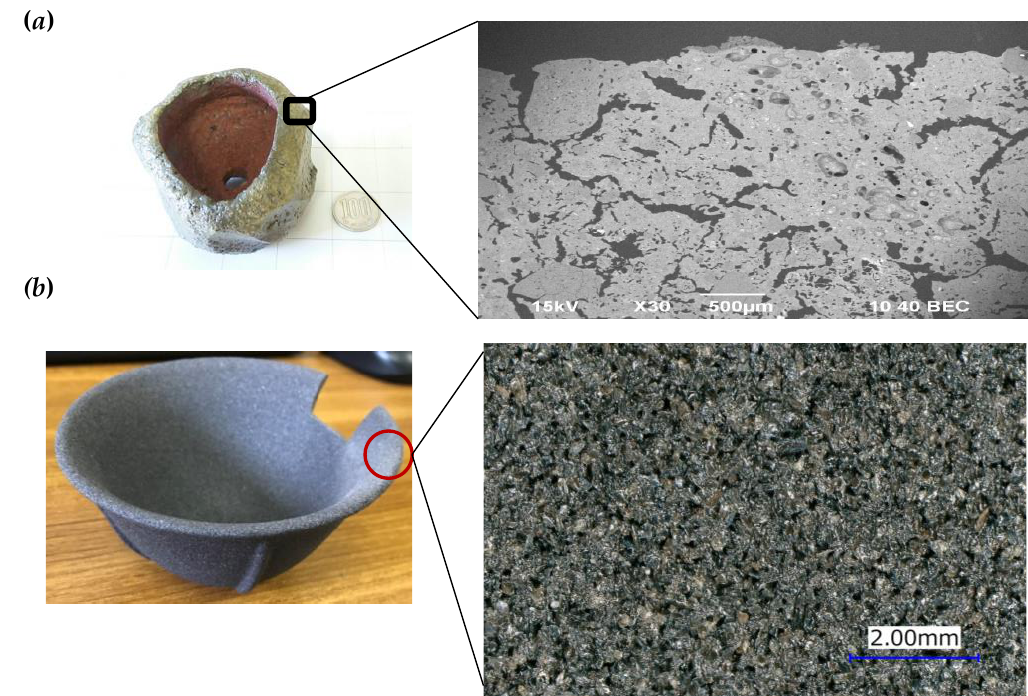
Figure 2. Real porous structures: ( a ) a clay-based ceramics pot; and ( b ) a ceramics coffee filter. Figure ( a ) (right-hand-side figure) is reprinted with permission from ref. [62]. Copyright 2021 ELSEVIER LICENSE.